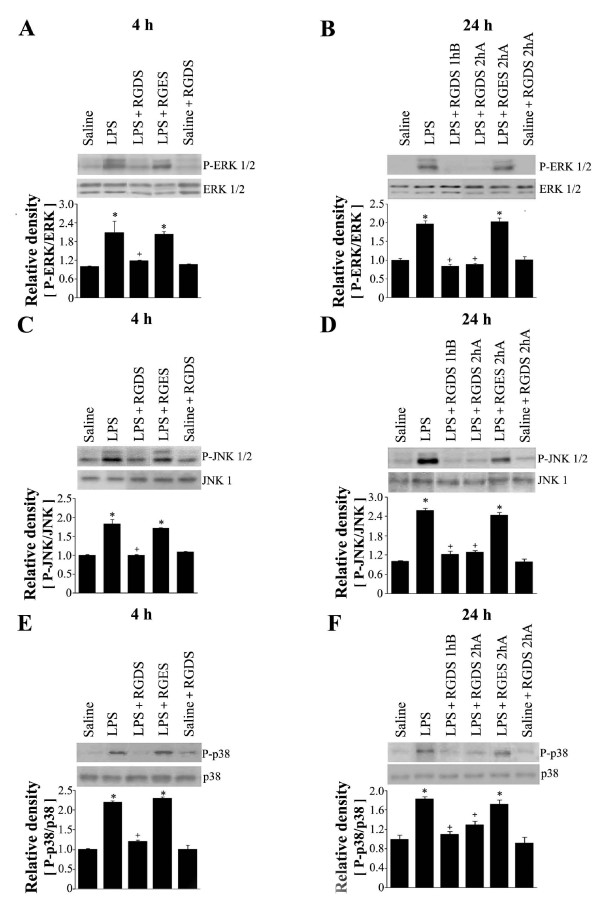
Effects of RGDS on phosphorylation of ERK1/2 (A, B), JNK1/2(C, D) and p38 MAP kinase (E, F) in lung tissue. Where indicated, mice were administered RGDS or RGES (5 mg/kg, i.p.) once 1 h before LPS treatment and sacrificed 4 h post-LPS. Mice were also administered these peptides (5 mg/kg, i.p.) once 1 h before or 2 h after LPS and sacrificed 24 h post-LPS. Western blotting was performed with each anti-specific (phospho) Ab on lung tissue homogenates. Relative values for phosphorylated MAP kinase versus MAP kinase, respectively, are indicated below the gel. Values represent means ± SEM of 5 mice per group. *Significantly different from saline treated controls, p < 0.05; +significantly different from animals treated with LPS only, p < 0.05.